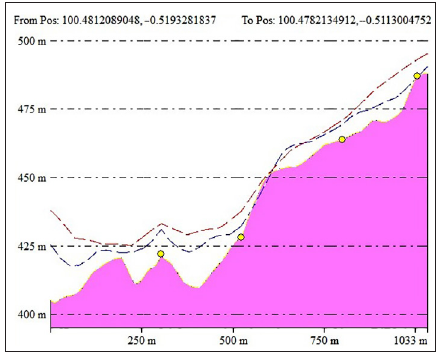
Figure 18. The change in Semangko fault using the longitudinal profile (northern Lake